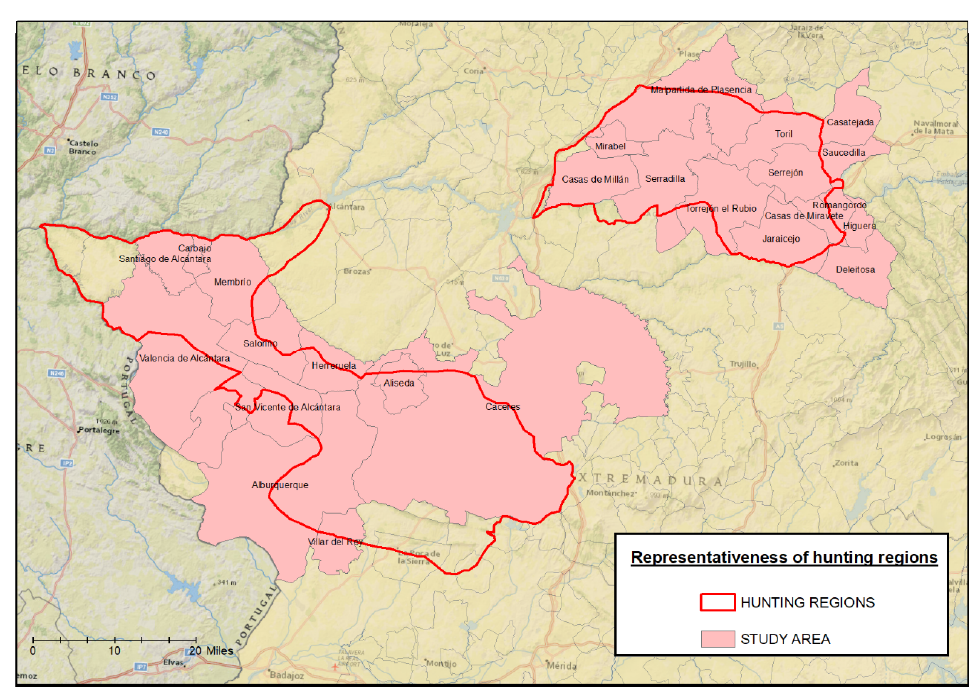
Figure 2. Representativeness of hunting regions.